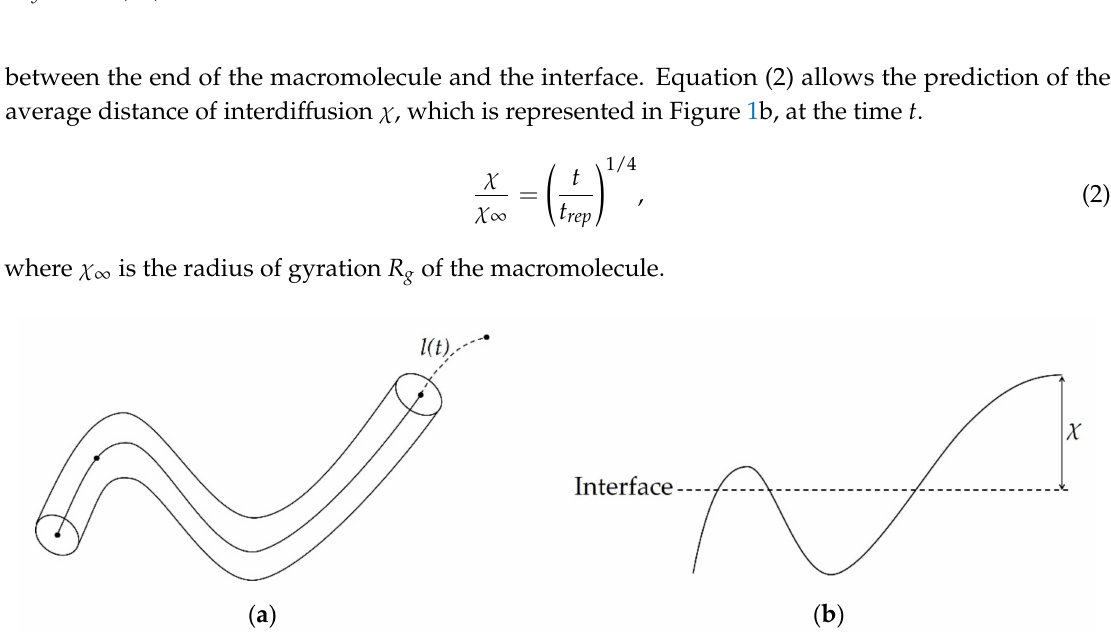
Figure 1. ( a ) Minor chain length l(t) according to the reptation theory; ( b ) Interpenetration distance of a chain across the interface. Adapted from